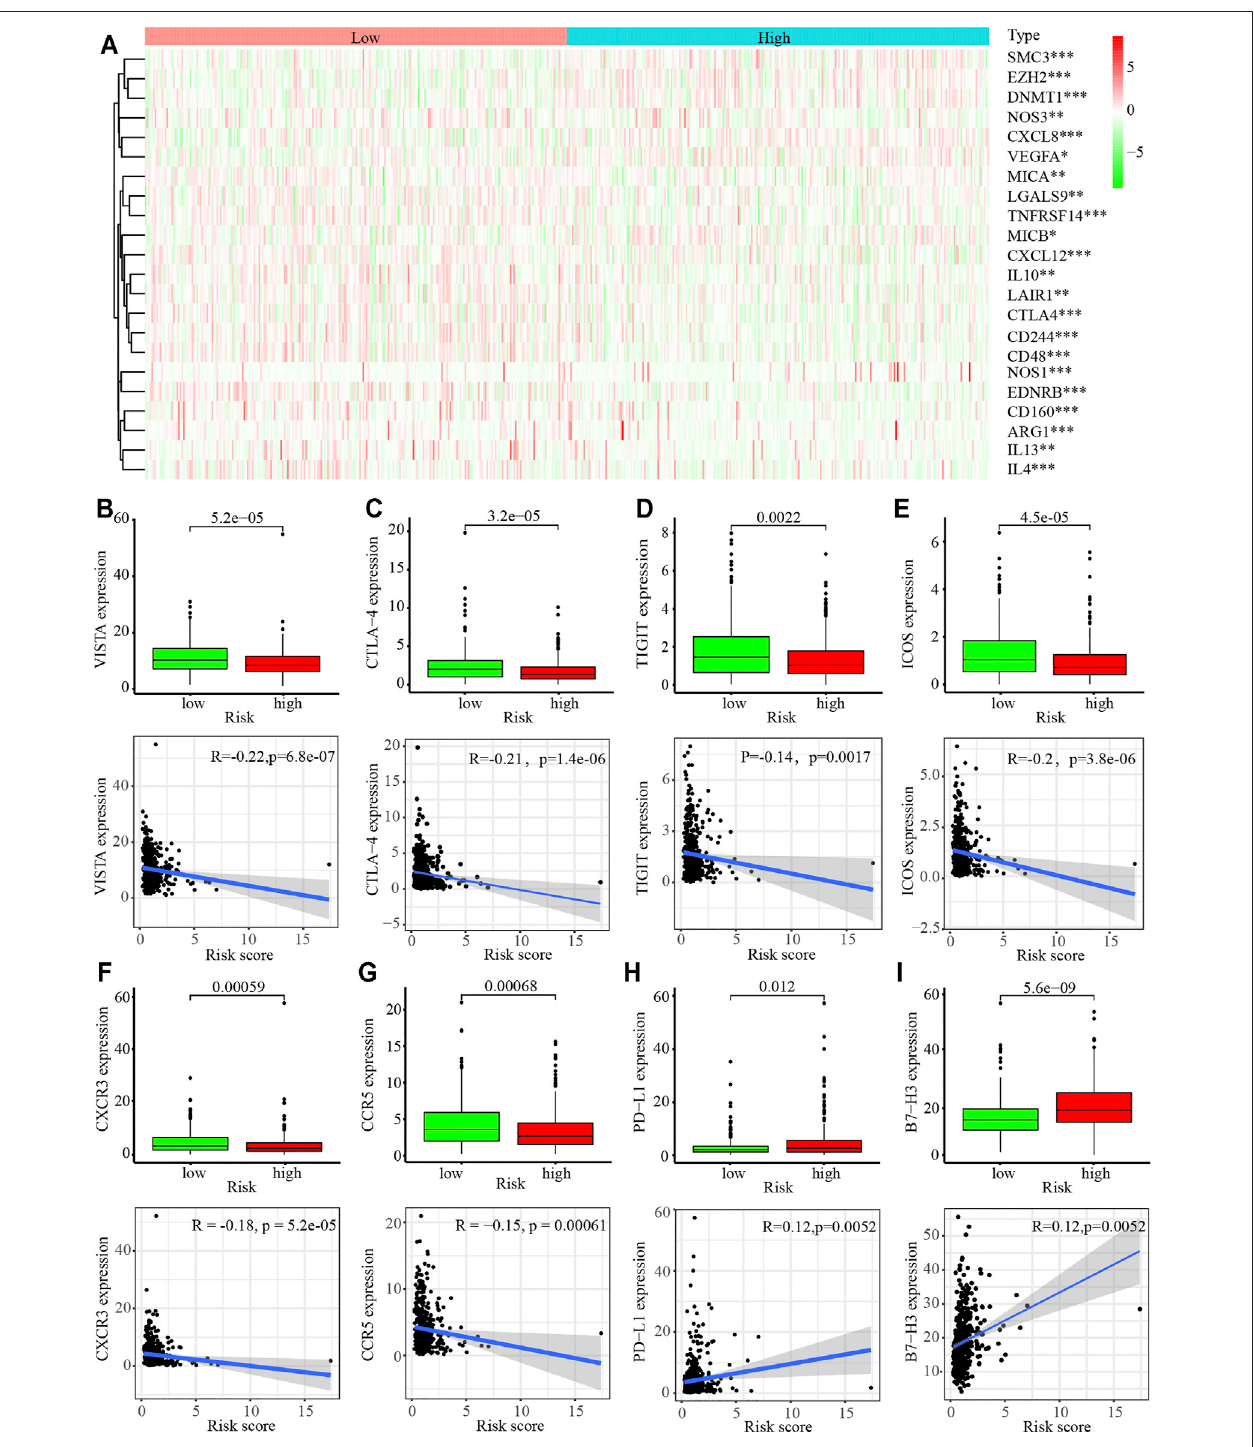
FIGURE6| Immune cellin fi ltrationinthetumor microenvironment(TME)inLUAD. (A) Heatmap ofimmune-relatedgenesetsbetweenthehigh-and low-riskLUAD patients. (B – G) Expression of VISTA (B) , CTLA4 (C) , TIGT (D) , ICOS (E) , CXCR3 (F) , CCR5 (G) PD-L1 (H) , and B7-H3 (I) in high- and low-risk LUAD patients.